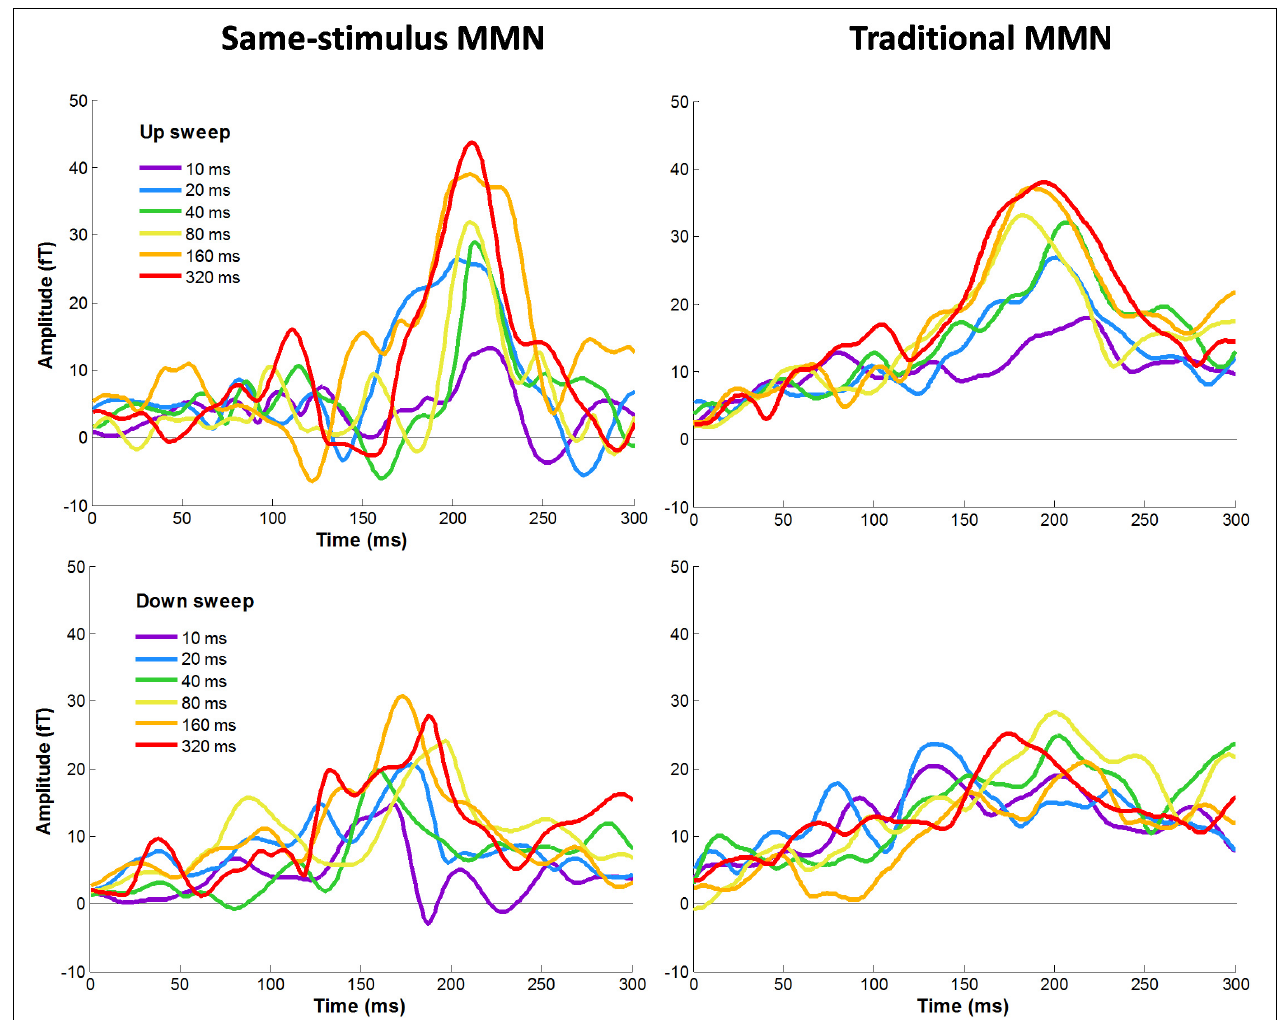
FIGURE 4 | Grand-averaged MMNm responses for each upward (top panel) and downward (bottom panel) FM sweeps as a function of sweep duration. Left and right panels show MMNm waveforms calculated using same-stimulus and traditional methods, respectively. Different color lines represent different sweep duration condition. Responses were averaged across